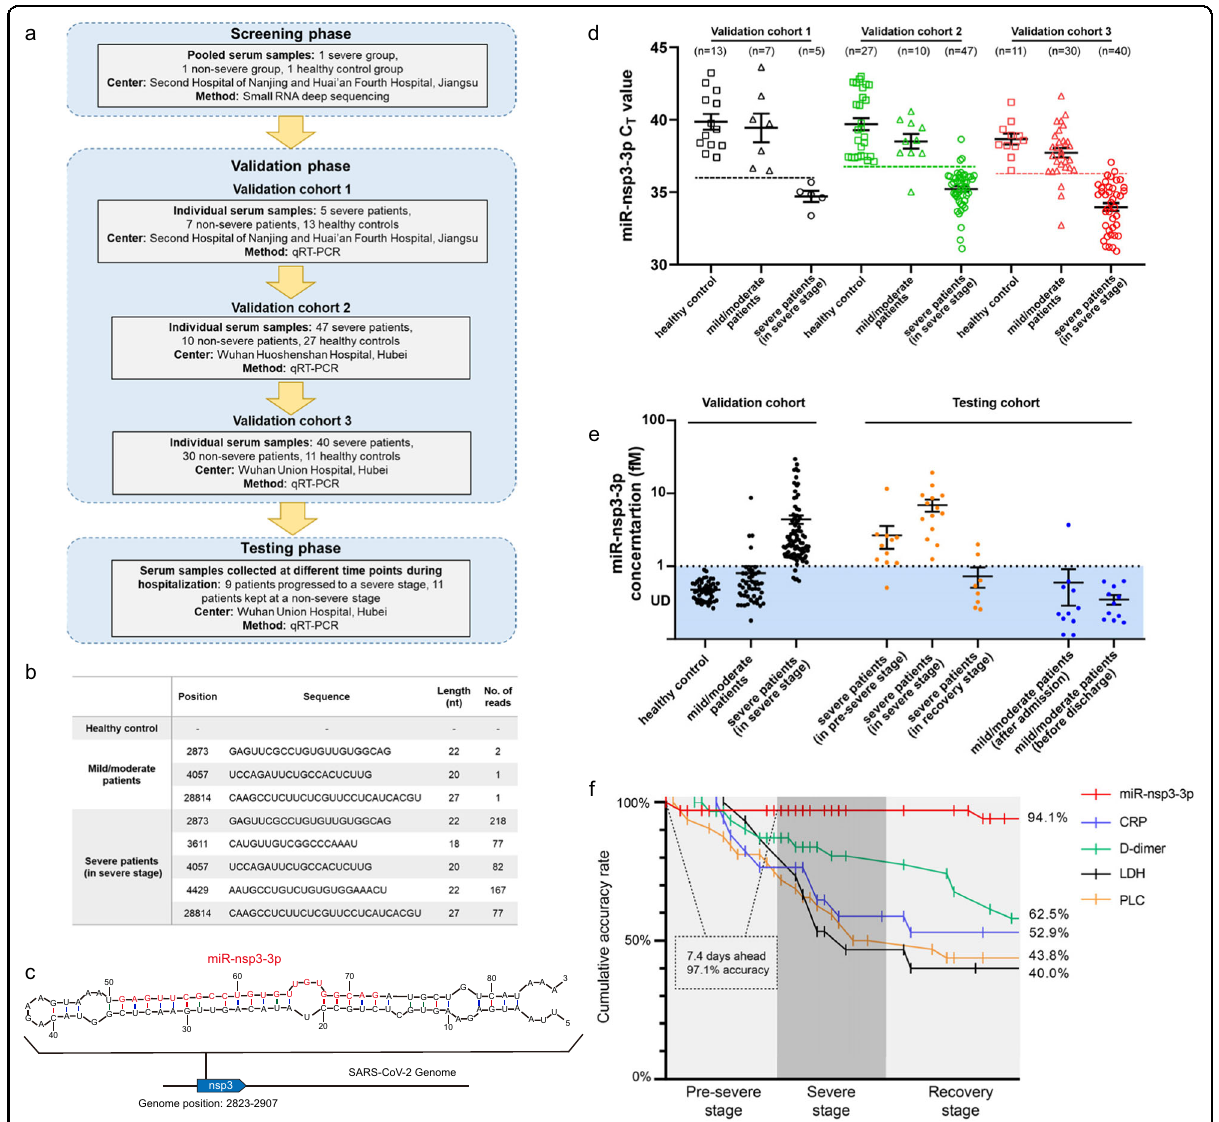
Fig. 1 Identi fi cation and detection of milRNAs of SARS-CoV-2 in the sera from COVID-19 patients. a Overview of the study design. b SARS- CoV-2-derived small RNAs in the sera of COVID-19 patients and healthy controls. c Genomic position and stem-loop structure of the precursor of miR- nsp3-3p. Mature miR-nsp3-3p is indicated in red. d The individual C T values of miR-nsp3-3p in the serum from severe patients, mild/moderate patients, and healthy controls in the validation cohorts 1, 2, and 3. Serum samples were collected from mild/moderate patients who remained at a mild or moderate condition or from severe patients who had developed a severe or critically severe illness. The lower boundary of the detection spectrum of each cohort is indicated by a dotted line. e The absolute concentrations of miR-nsp3-3p in the serum from validation and testing cohorts. In testing cohort, serum samples were collected from mild/moderate patients at the time of admission and before discharge or from severe patients when the disease progressed from pre-severe stage (before manifestation of severe symptoms) to severe stage and then to recovery stage. f The cumulative accuracy rate of miR-nsp3-3p, D-dimer, CRP, LDH, and PLC in predicting the risk of critical illness and monitoring disease